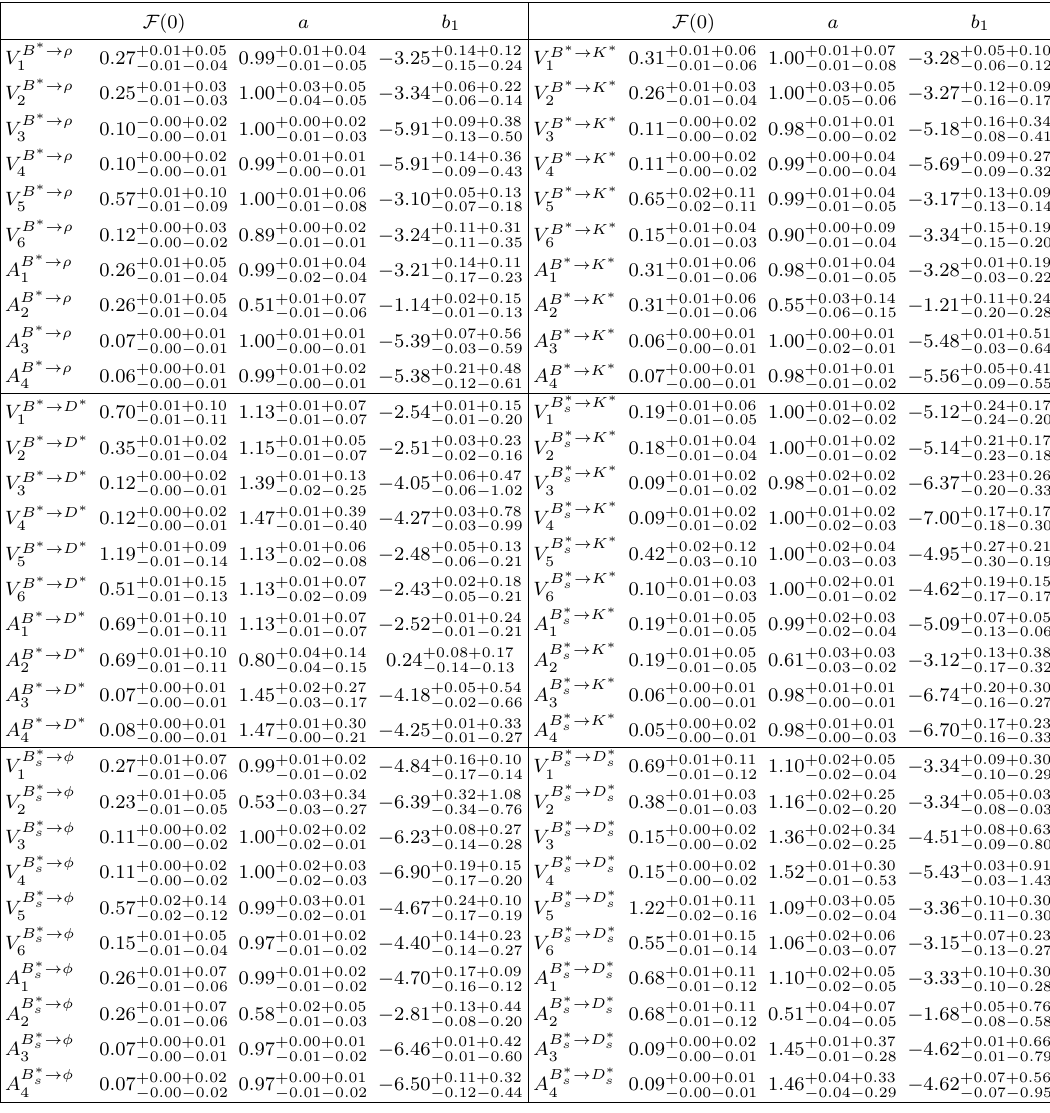
Table 5 . Same as table 4 except for b ! ( q; s; c ) induced B (cid:3) ! ( (cid:26) ; K (cid:3) ; D (cid:3) ) and B s ! ( K (cid:3) ; (cid:30) ; D (cid:3) transitions. The errors are due to parameters (cid:12) and quark masses only (cf. section 4 for a more complete